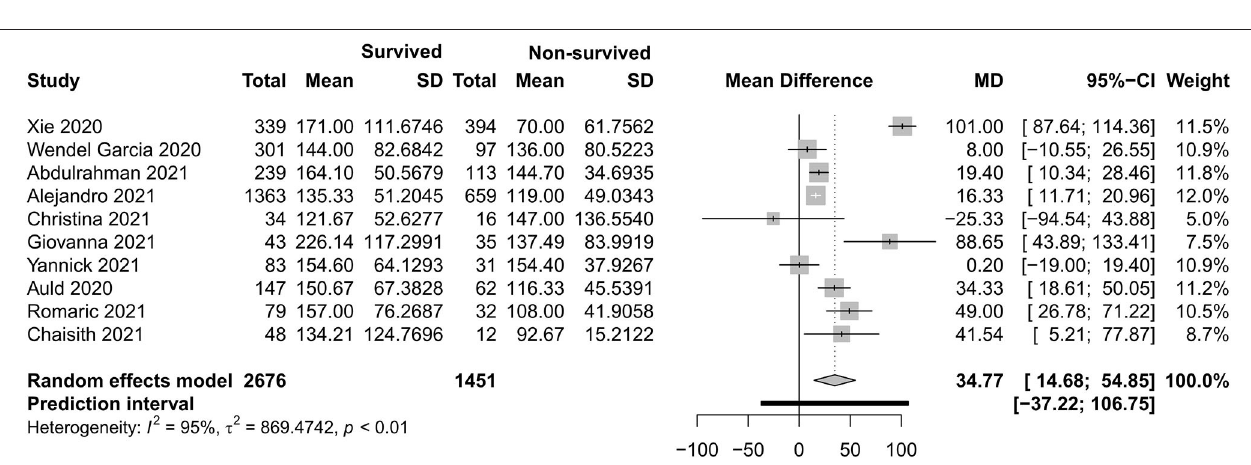
FIGURE 7 | Mean difference of the PaO 2 /FiO 2 ratio between survived and non-survived